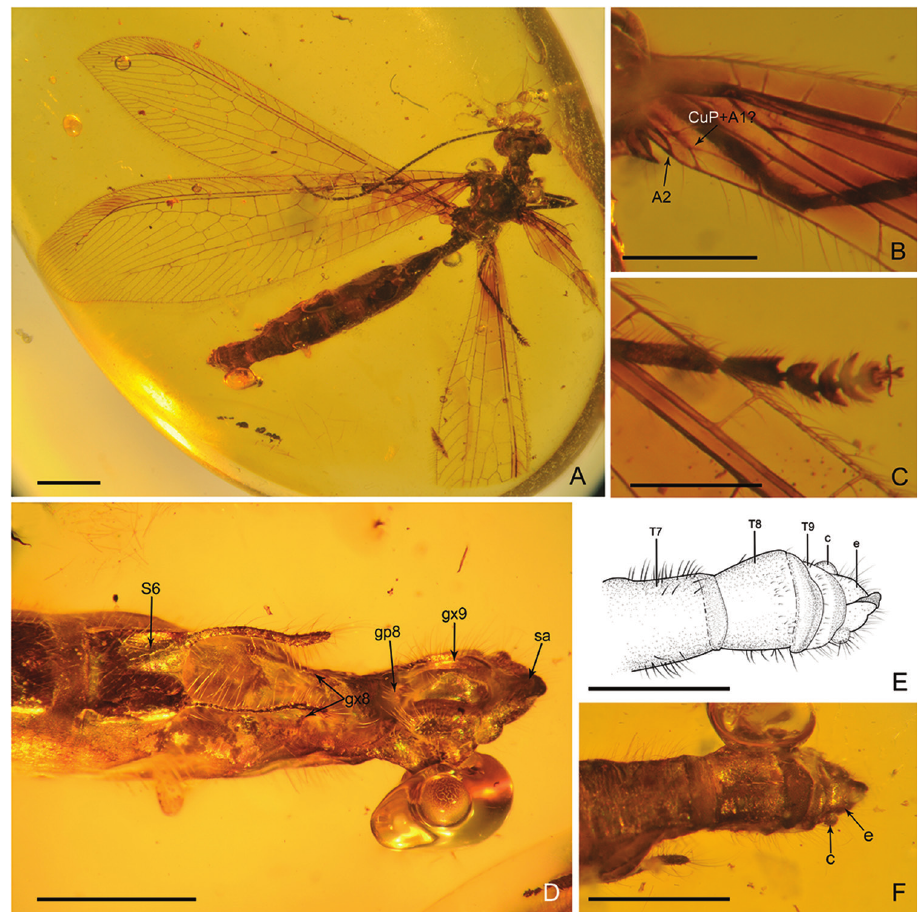
Figure 5. Electrobabinskaia burmana Lu, Zhang & Liu, 2017, female. A Habitus photograph, dorsal view B Photograph of right wing base C Photograph of tarsus D Photograph of female genitalia, ven- tral view E Line drawing of female genitalia, dorsal view F Photograph of female genitalia, dorsal view. Abbreviations: T: tergum; S: sternum; c: callus cercus; e: ectoproct; gp: gonapophysis; gx: gonocoxite; sa: subanale. Scale bars: 0.5 mm ( C ); 1.0 mm ( A–B, D–F